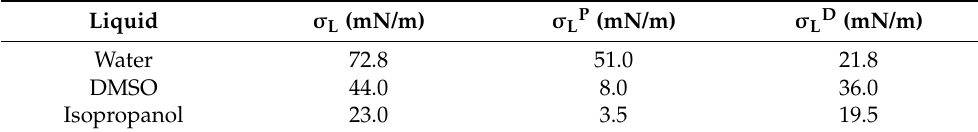
Table A1. Surface tension and components of solvents [16,36,37].